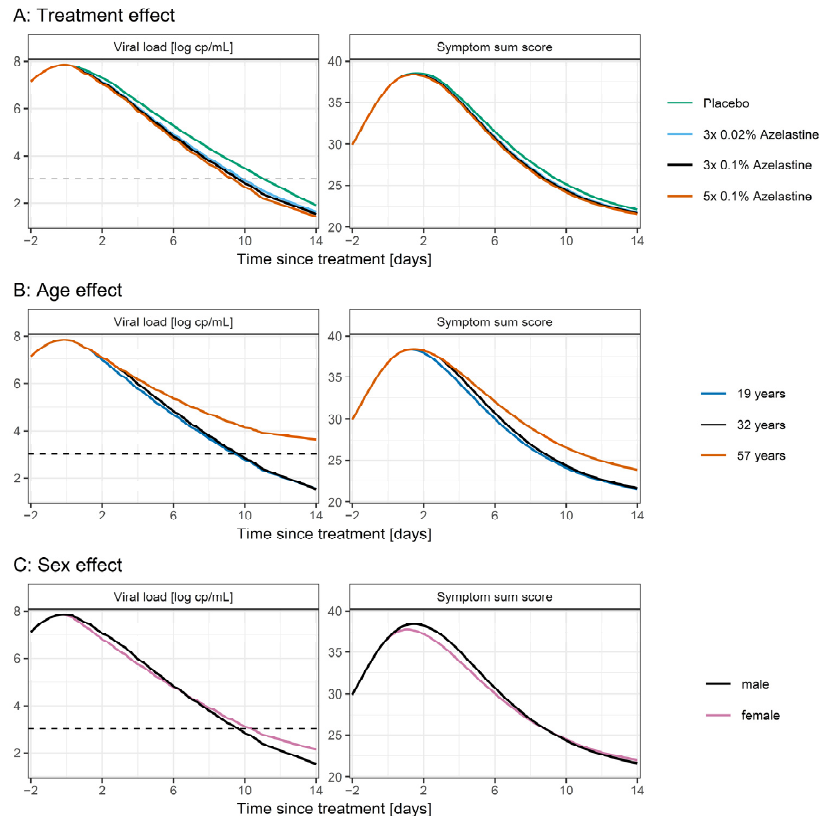
Figure 4. Scenario simulations of the viral load and symptom sum score dependent on univariate changes in treatment ( A ) or the covariates age ( B ) and sex ( C ). Black lines represent the standard patient (32 years, male) receiving 3 × 0.1% azelastine treatment. Colored lines indicate the univariate change of the respective covariates. Dashed lines indicate the LLOQ of the viral load.